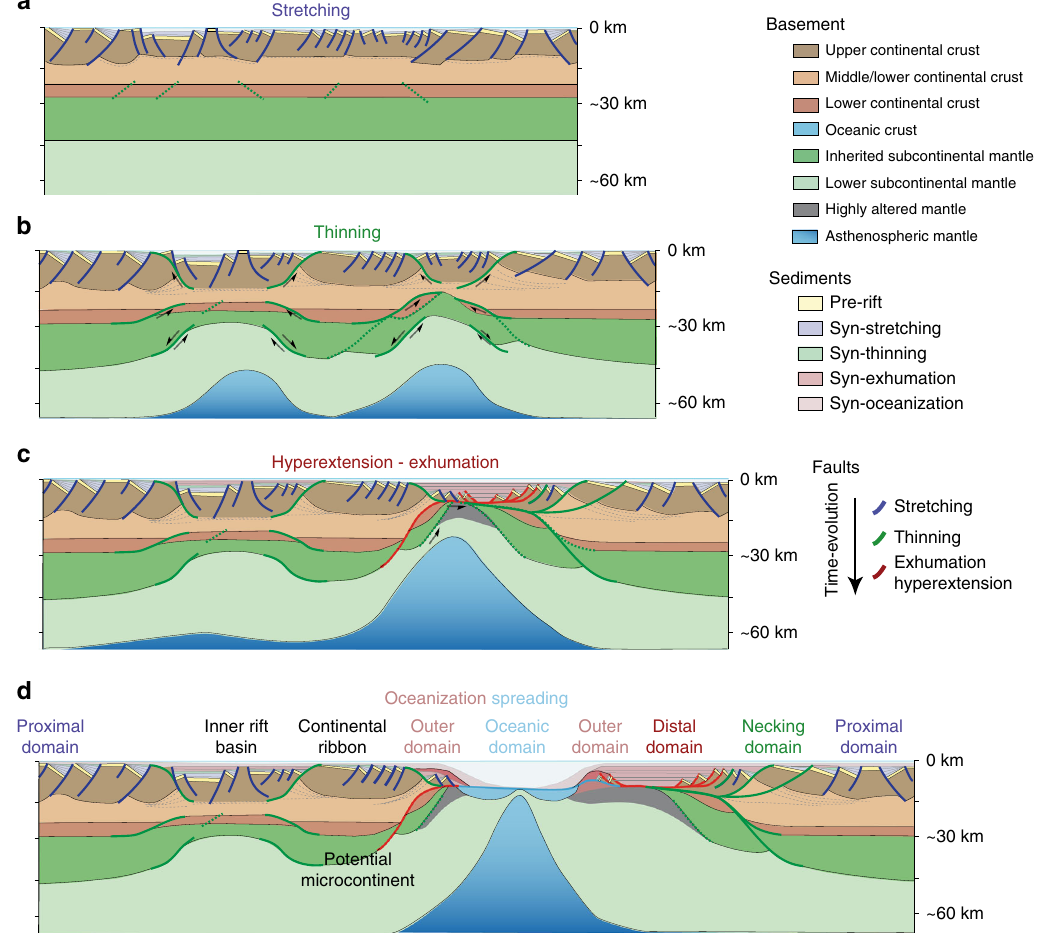
Fig. 1 Schematic model of the phases of rifted margin formation. a In the stretching phase, extension is accommodated by distributed faulting in the upper crust, resulting in a distributed reduction of crustal thickness. b In the thinning phase, deformation localizes in focused areas characterized by deformation coupling, formation of lithospheric-scale shear zones and uplift of the asthenosphere. c In the hyper-extension and exhumation phases, the crust is thinned to such a degree that it behaves in a brittle-only manner. Large-scale detachment faults that cut through the lithosphere may bring water down to sub- crustal depths, thus initiating serpentinization. d The last phase of oceanization is characterized by crustal and lithospheric breakup and formation of oceanic crust. The margin domains link to their phase of formation as described in the text. The schematic model is reprinted with minor modi fi cations from Péron-Pinvidic, et al.